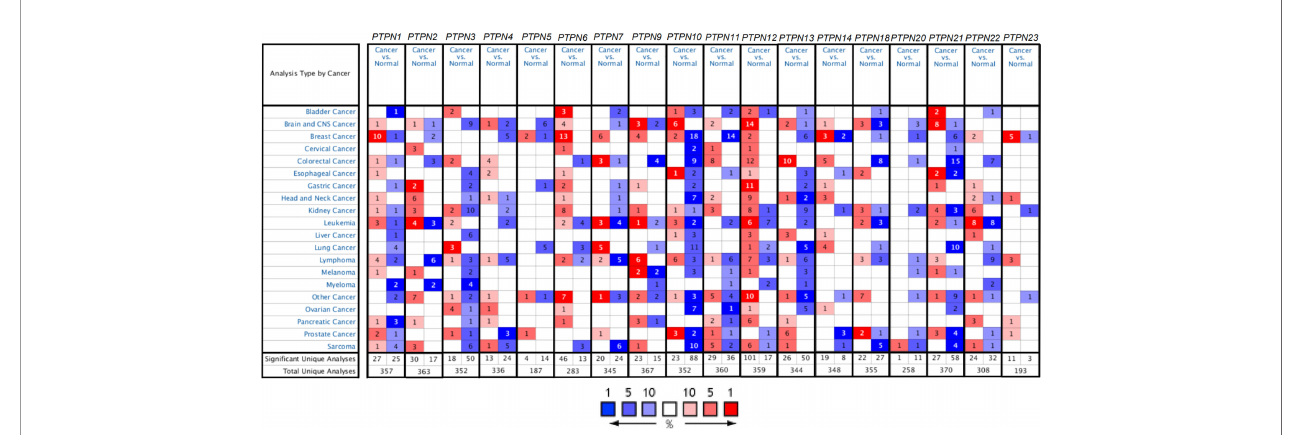
FIGURE 1 | The expression of PTPNs in various tumor tissues and normal tissues in the Oncomine database. Red and blue represent datasets of cancer and normal tissues, respectively. The darker color illustrates that the gene was ranked at approximately the top of the expression quantity in this tumor. The rank for a gene is the median rank for that gene across each of the analyses. And the number in the square represents the number of datasets that met our screening requirements (P <